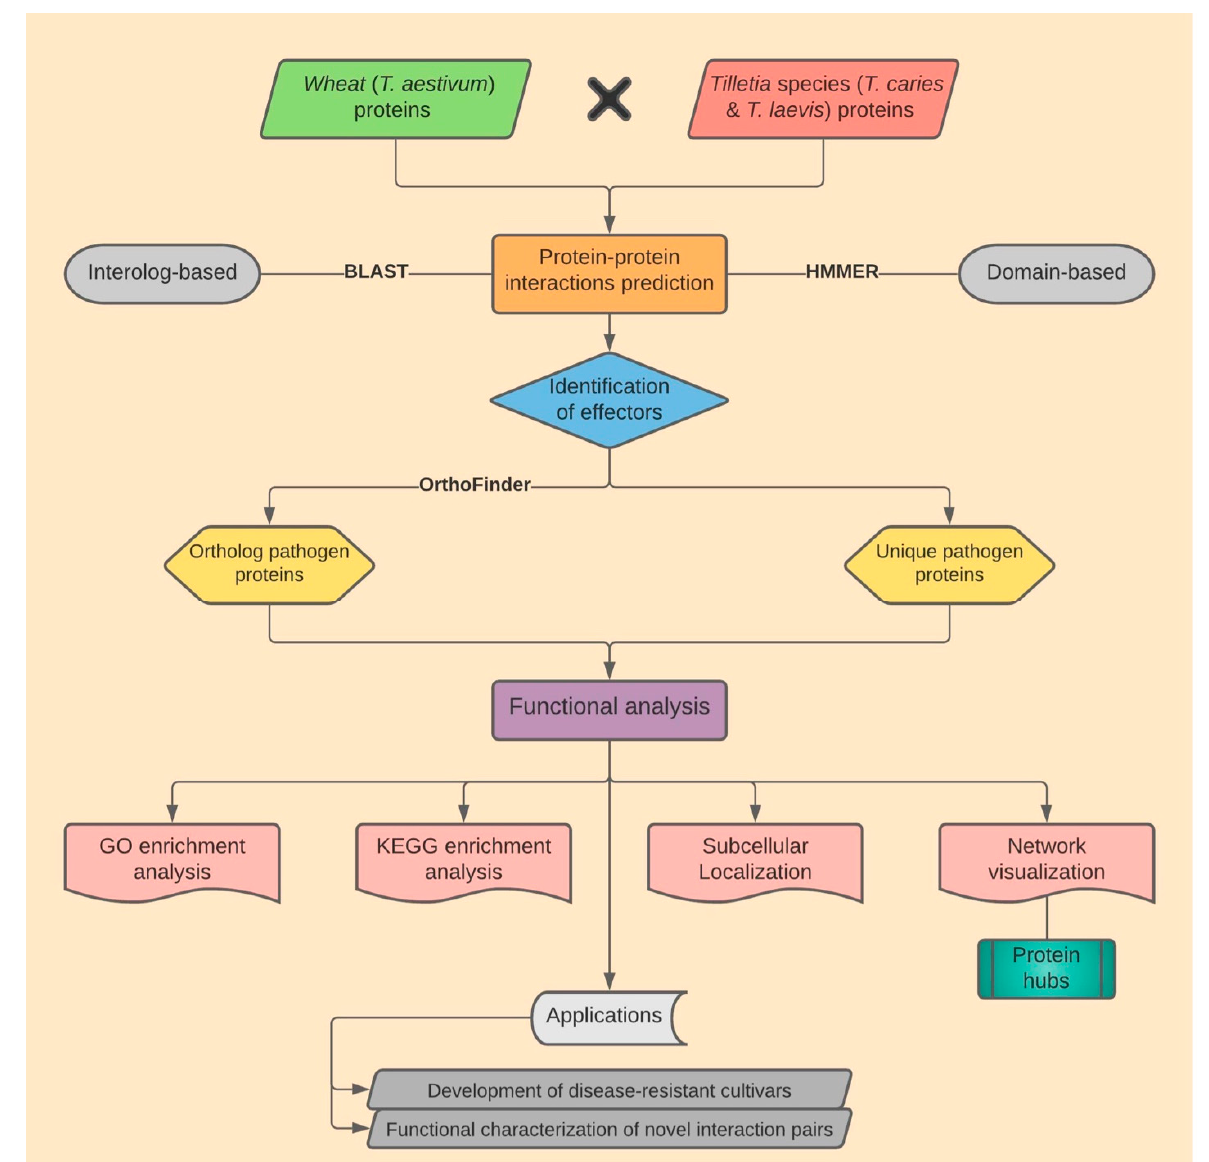
Figure 9. Overall workflow for protein–protein interaction prediction in the wheat–common bunt ( T. aestivum – Tilletia sp.) system. ( T. aestivum – Tilletia sp.)